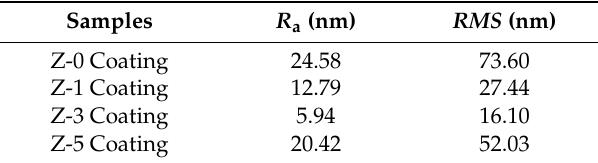
Table 2. R a and root mean square ( RMS ) values of different nano-ZrO 2 -modified coatings after 192 h of acid immersion, as deduced from AFM